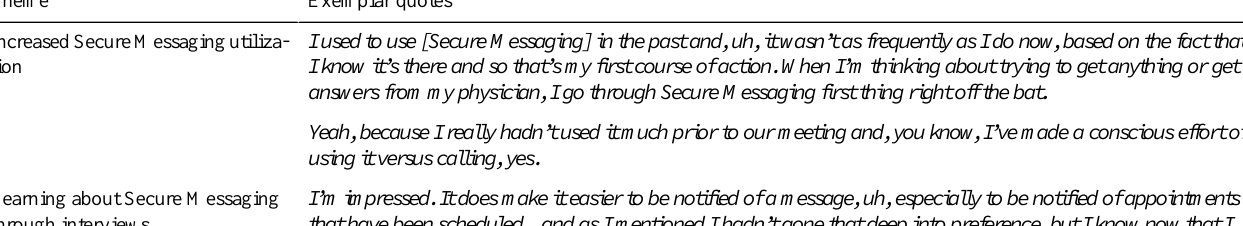
Exemplar quotesTheme